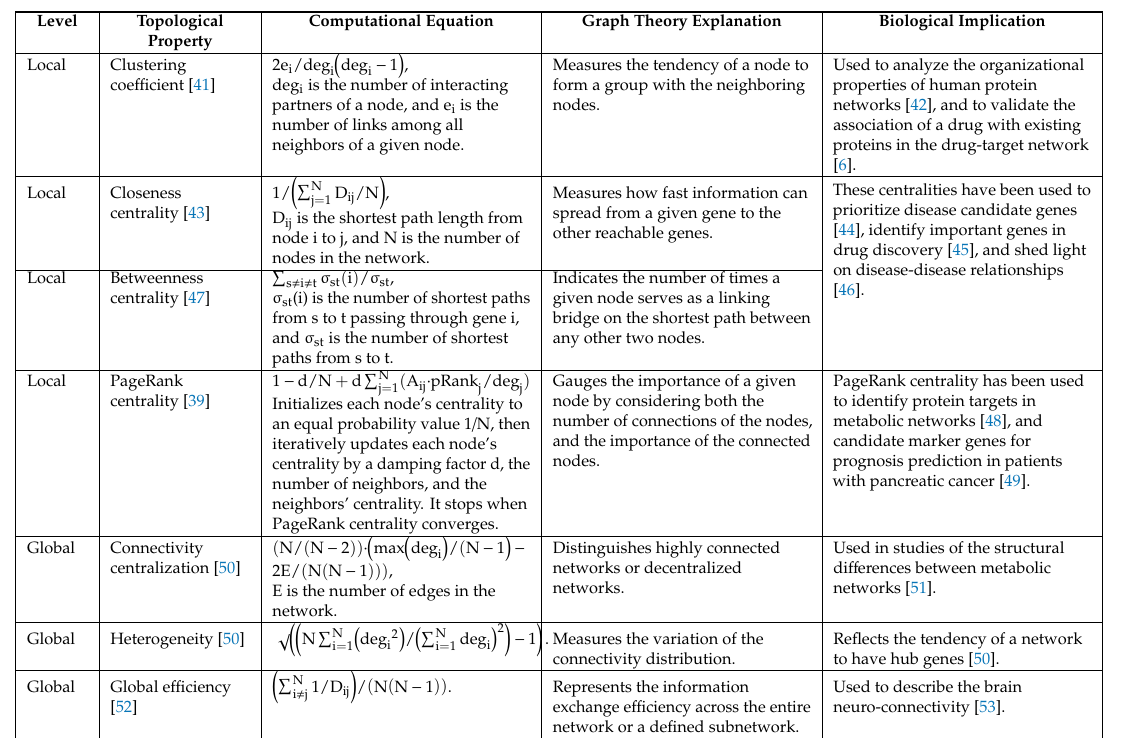
Table 2. Typical local and global topological properties (with their computational equations and graph theory explanation) that have been used in biological